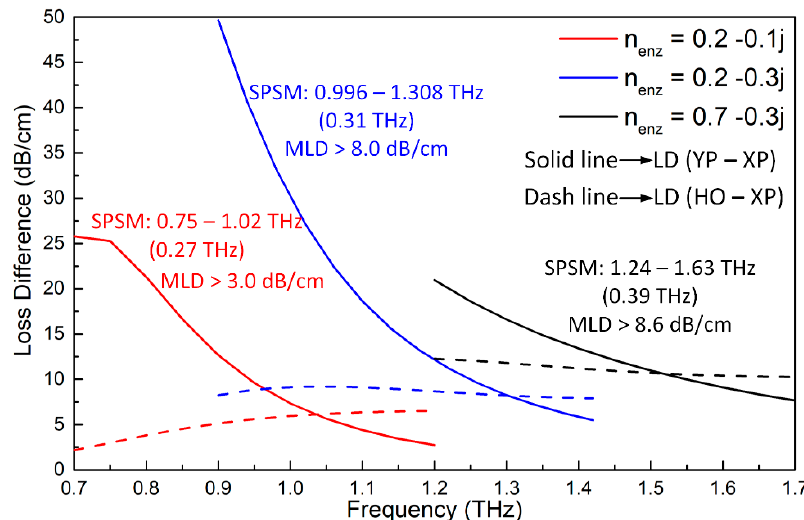
Figure 9. The LD values of the active ENZ-based PCF as functions of the frequency for different refractive index values, n enz .